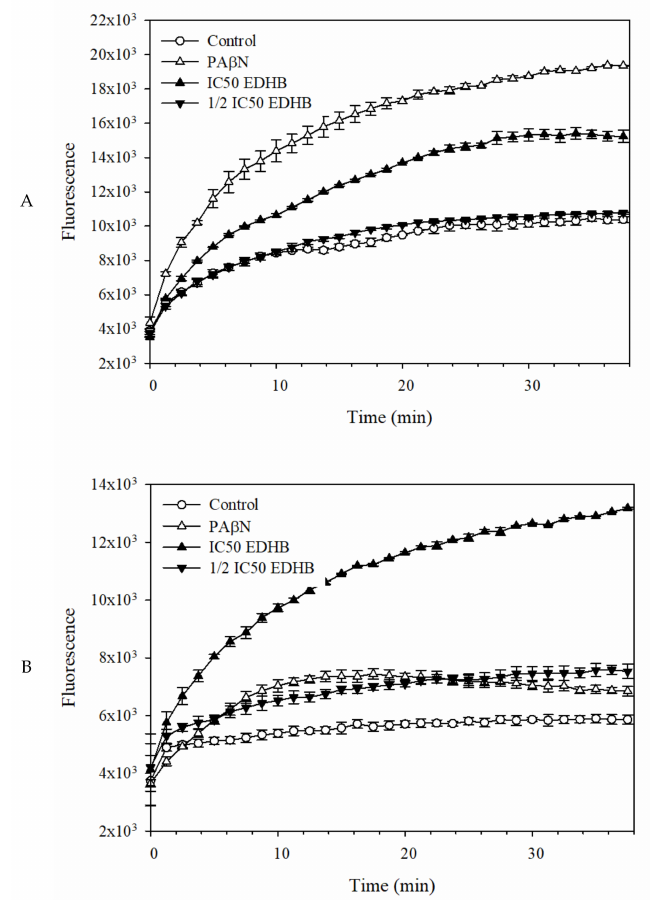
Figure 2. ( A ) H33342 and ( B ) EtBr accumulation of EDHB in E. coli Kam3-AcrB. The IC 50 of EDHB is 500 µ g/mL. Data are expressed as mean ± SD ( n =